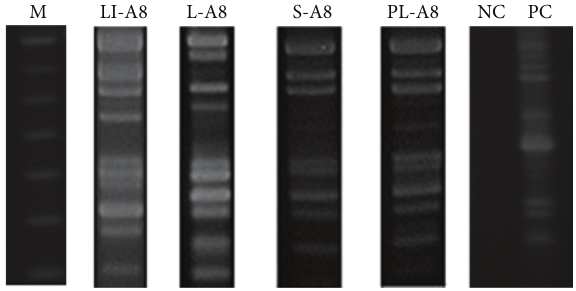
Figure 3: Agarose gel electrophoresis showing genetic profiles gen- erated by LSSP-PCR for cutaneous lesion and internal organs from the same animal. M: 100bp DNA ladder marker; LI-A8: liver frag- ment from animal 8; L-A8: cutaneous lesion fragment from animal 8; S-A8: spleen fragment from animal 8; PL-8: popliteal lymph node fragment from animal 8; NC: negative control; PC: positive control ( L . (V . ) braziliensis reference strain